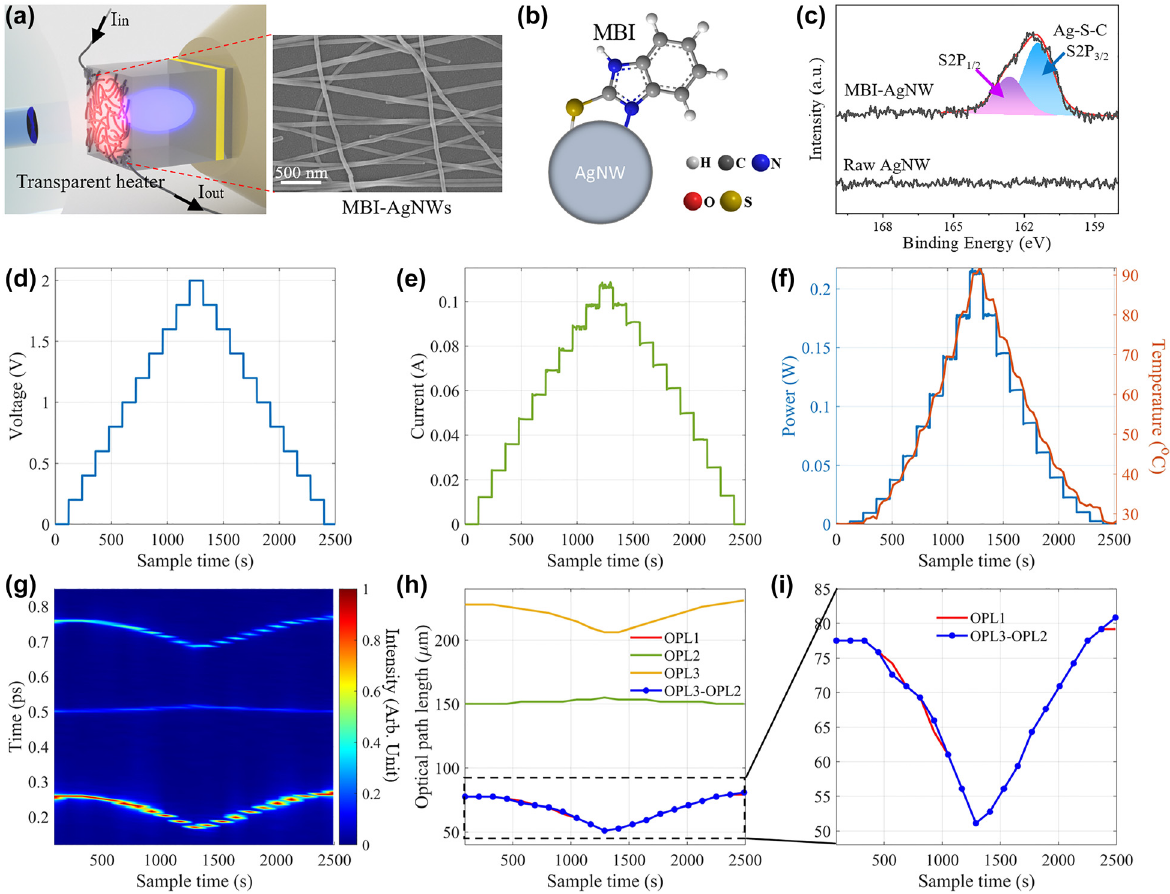
Figure 4: (a) Schematic illustration of the coupled resonators containing a AgNW-based transparent heater (left) and the scanning electron microscope(SEM)image of the MBISAM-modified AgNW networkonthe PDMSfilm resonator(right).The cross-linkedAgNW indicates a high- quality network. (b) Schematic of the AgNW modified with the MBI SAM via Ag – S and Ag – N bonds. (c) XPS S2P spectra of the raw AgNWs and MBI-modified AgNWs. A source meter applied voltage (d) and responded current (e) to the AgNW-based transparent heater. (f) The calculated power (left) and the corresponding temperature (right). (g) The mode components are observed from reciprocal space depending on the temperature. (h) The calculated OPL of modes I, II, and III. (i) Zoom in the OPL to compare the OPL1 and